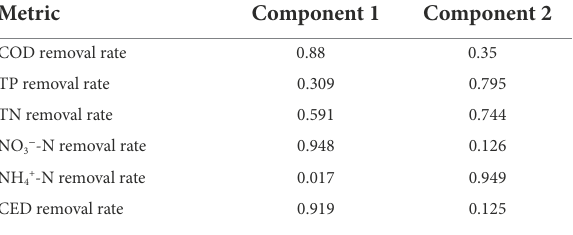
TABLE 2 Table of the factor load matrix after the orthogonal rotation.